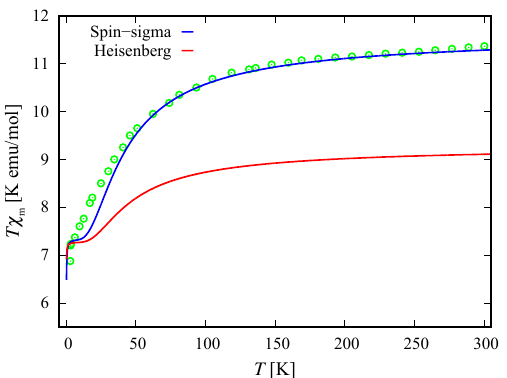
Figure 6. Molar susceptibility of Na 9 [Er(W 5 O 18 ) 2 ] as a function of temperature, multiplied by the temperature. The experimental data (green circles) from Reference [9] are shown along with the theoretical results (solid lines) for B = 0.1 T and b = 0 T. The susceptibility obtained with the aid of spin–sigma Hamiltonian (1) is depicted by a blue line. The red one shows the calculations performed with the Heisenberg model.